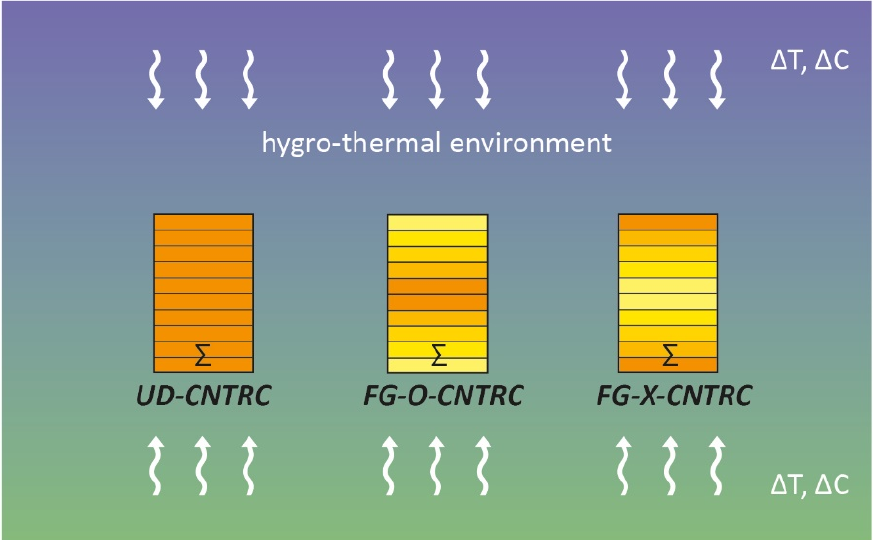
Figure 2. Schematic representation of a multilayered FG-CNTRC nano-beam with different patterns of CNTs dispersions: uniform distribution (UD-CNTRC); non-uniform functionally graded distributions type “O” (FG-O-CNTRC); non-uniform functionally graded distributions type “X”